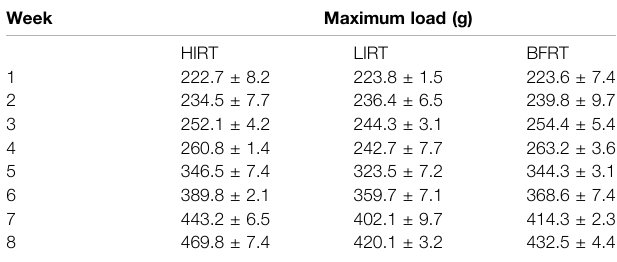
TABLE 1 | The maximum load of the exercise